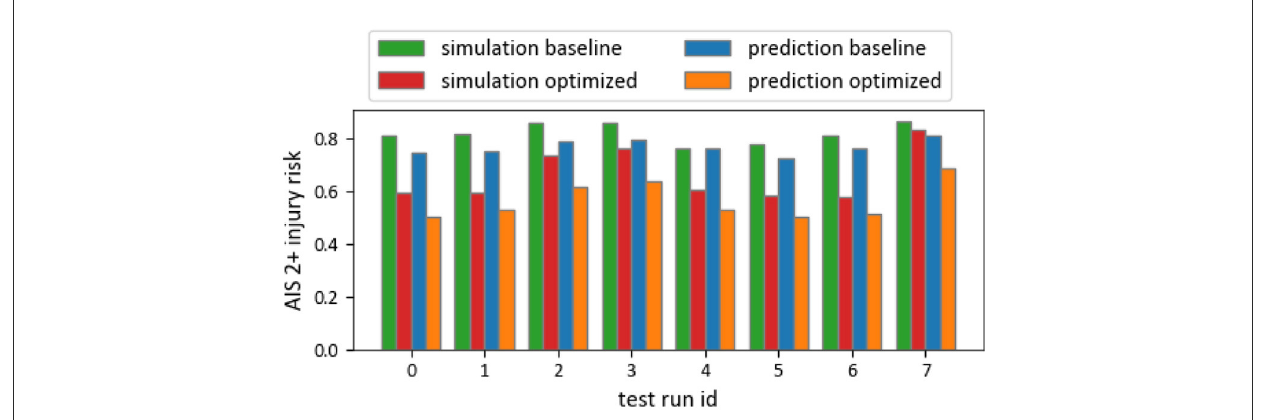
FIGURE14 Comparison of prediction and simulation results with and without optimized restraint system parameter for a selected subset of the available scenarios.